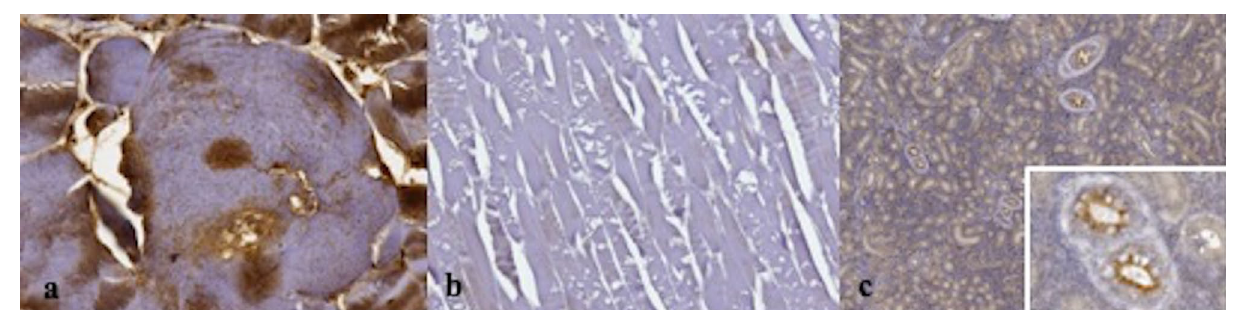
Figure 3. Immunohistochemical (IHC) pattern. ( a ) Strong intracytoplasmic positive immunoreaction for fibrinogen in affected myocytes, skeletal muscle, common carp. IHC for fibrinogen ad Mayer’s hematoxylin counterstain, ×40 magnification. ( b ) Severe diffuse depletion of myoglobin in degenerated myocytes is demonstrated by the absence of immunoreaction for myoglobin, skeletal muscle, common carp. IHC for myoglobin and Mayer’s hematoxylin counterstain, ×10 magnification. ( c ) The apical cytoplasm of tubular cells shows positive immunoreaction for myoglobin, kidney, common carp, ×4 magnification. At the right corner a particular of tubular cells. IHC for myoglobin and Mayer’s hematoxylin counterstain, ×40